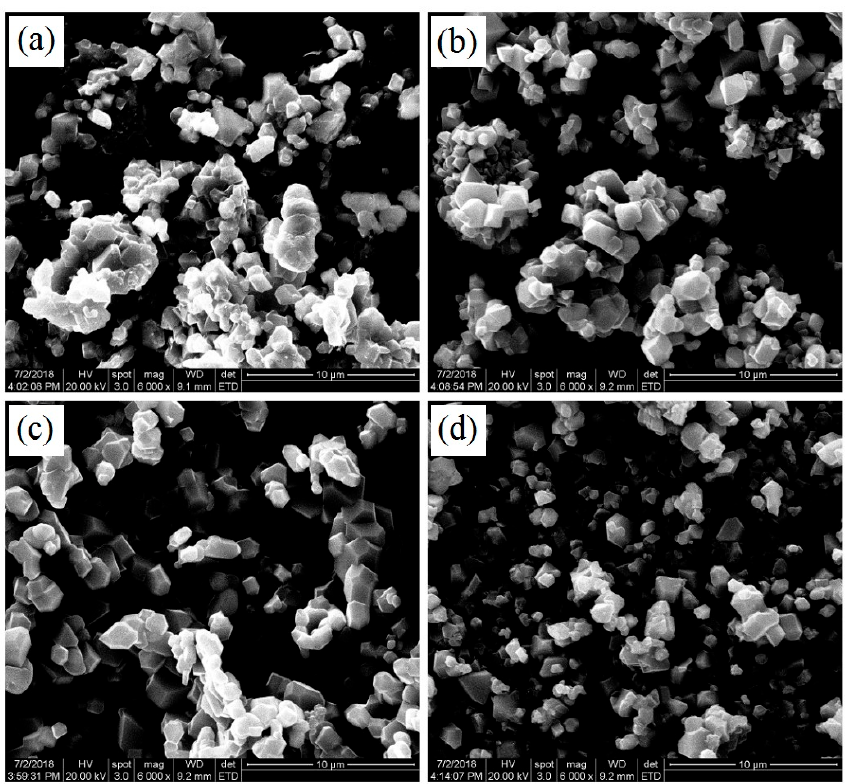
Figure 2. SEM images of LiCu x Mn 1.95-x Si 0.05 O 4 samples: ( a ) x = 0; ( b ) x = 0.02; ( c ) x = 0.05; ( d ) x = 0.08.